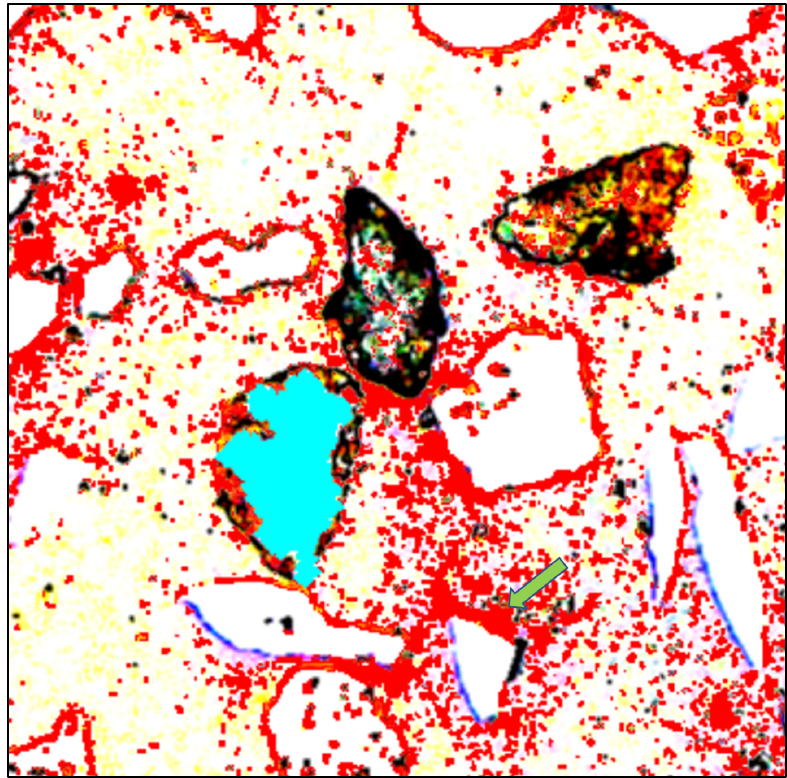
Figure 10. “Threshold” view of the image from Figure 8, green arrow shows “shade” near an opaque particle. For original image see Figure 2.